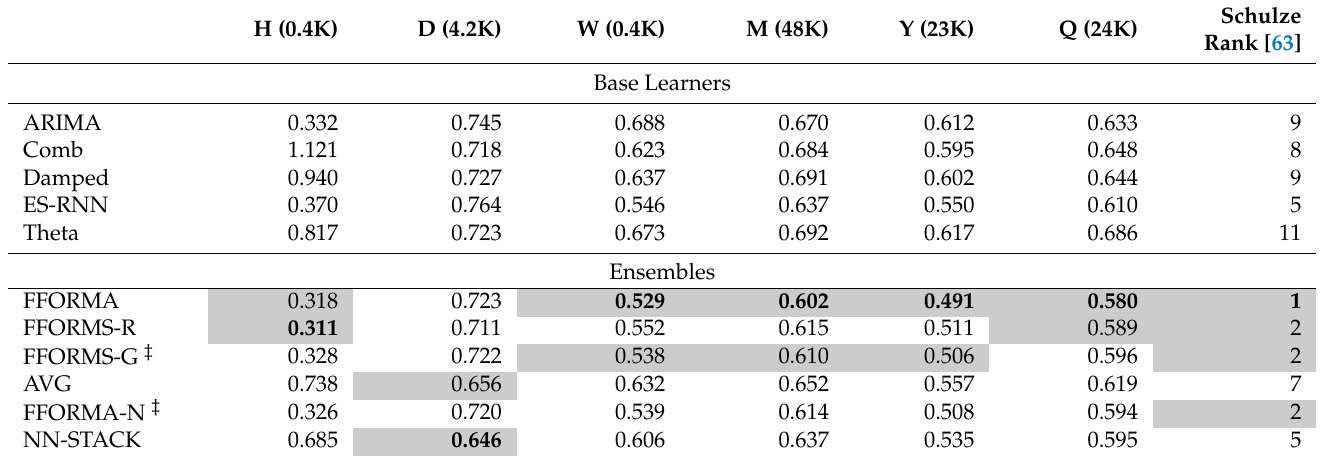
Table 4. Median OWA errors on the M4 test set, where lower values are